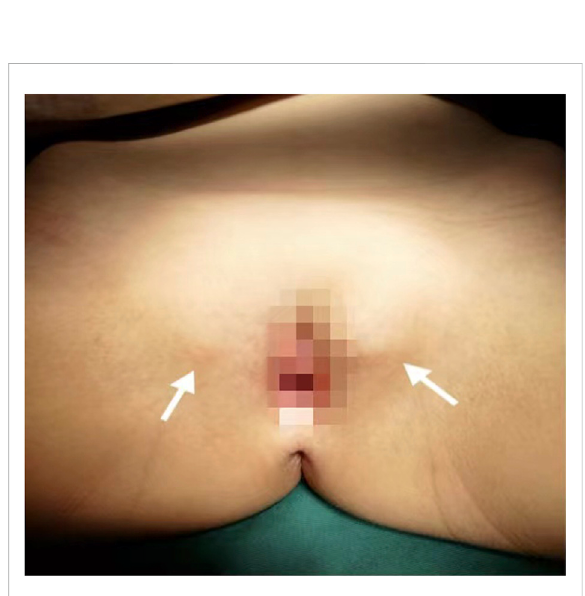
FIGURE 2 Patient ’ s female genitalia showing bilateral subcutaneous masses indicated by white